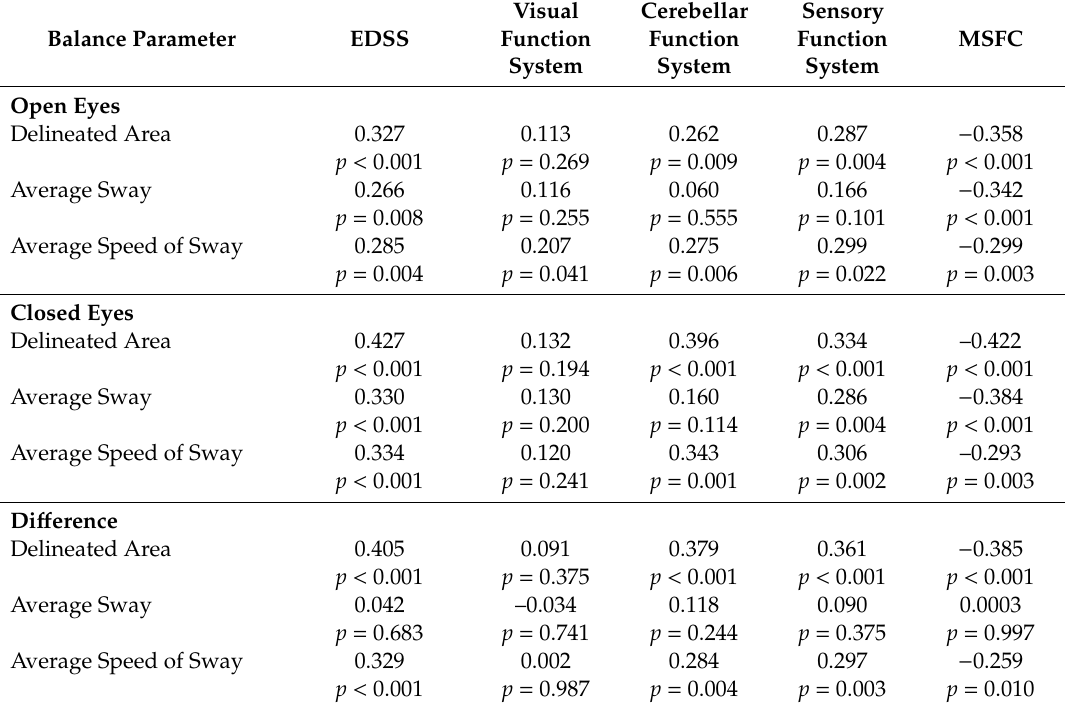
Table 4. Correlation of static posturography outcomes with clinical stablished tests in